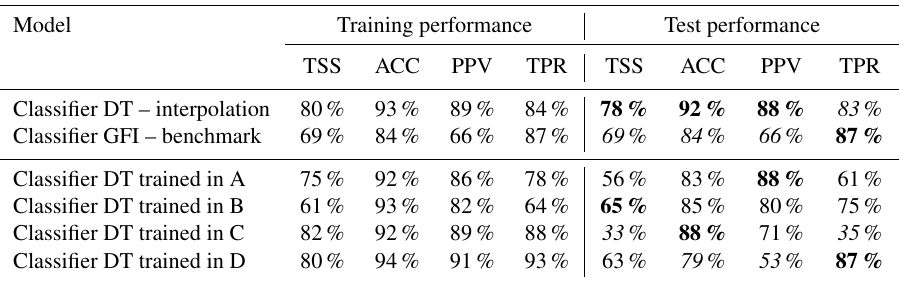
Figure 6. Training areas (bold contour) used for the geographical extrapolation experiments performed in phase 4, with major rivers and lakes highlighted in black. Table 1. Classification problem: performance metrics for the multivariate (classifier DTs) and univariate (classifier GFI) flood susceptibility maps; target flood hazard map for both approaches: PGRA P1. The reported values have been converted from the interval 0 − 1 to the percentage notation. The best testing metric values are reported in bold, the worst ones in italic (the first line should be compared with the second one; the last four lines should be compared to each